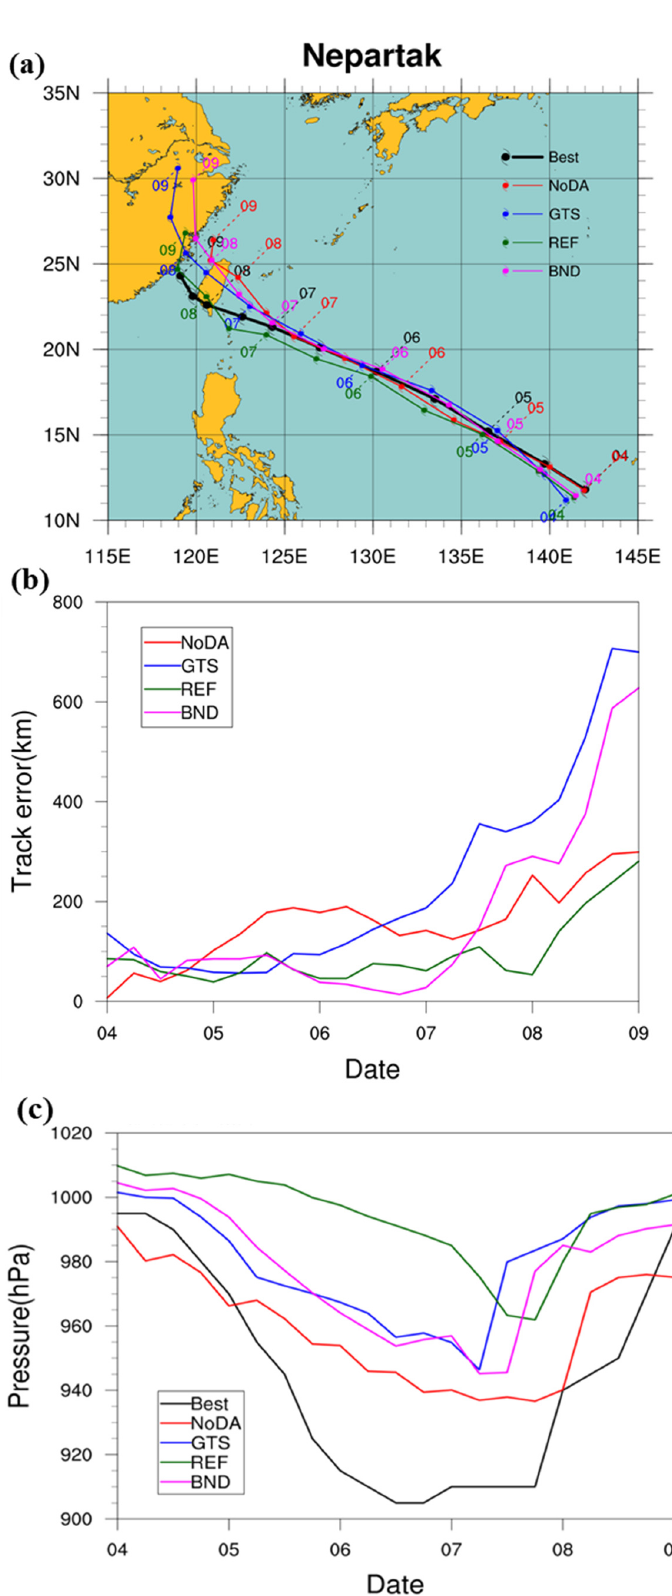
Figure 6. ( a )The CWB best track (black) and the forecasted tracks for BND (pink line), REF (green line), GTS (blue line), and NoDA (red line) for Typhoon Nepartak. ( b ) as in ( a ) but for the evolution of the track errors with forecast time, and ( c ) as in ( b ) but for the central sea-level pressure of the typhoon.